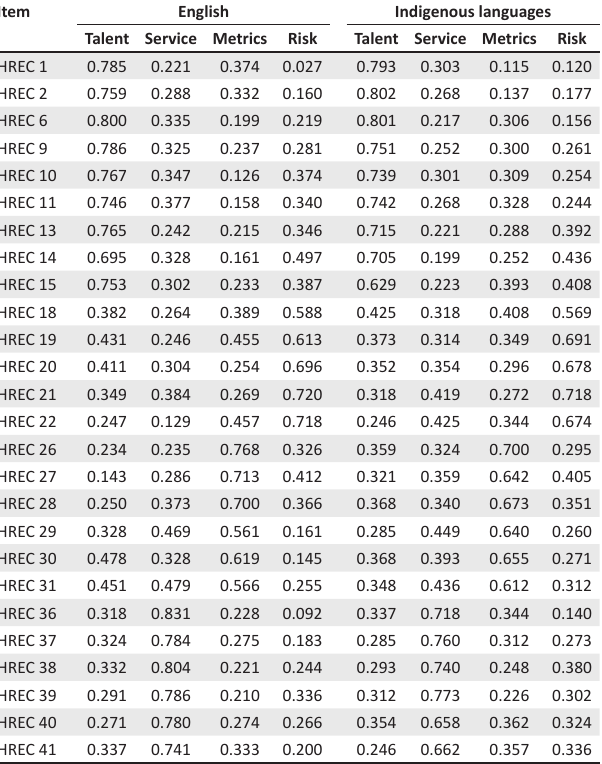
TABLE 2: Rotated component matrix for the service orientation and execution dimension.